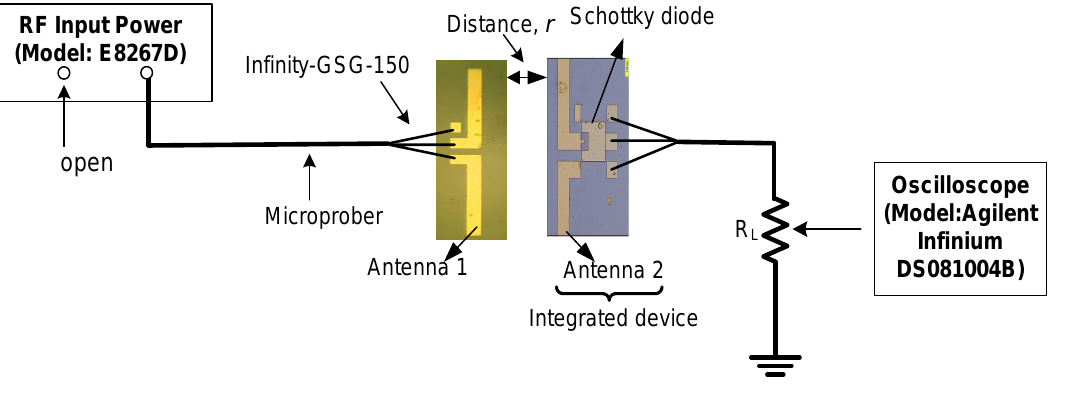
Figure 9. Rectified output voltages as a function of input power at distance of 2